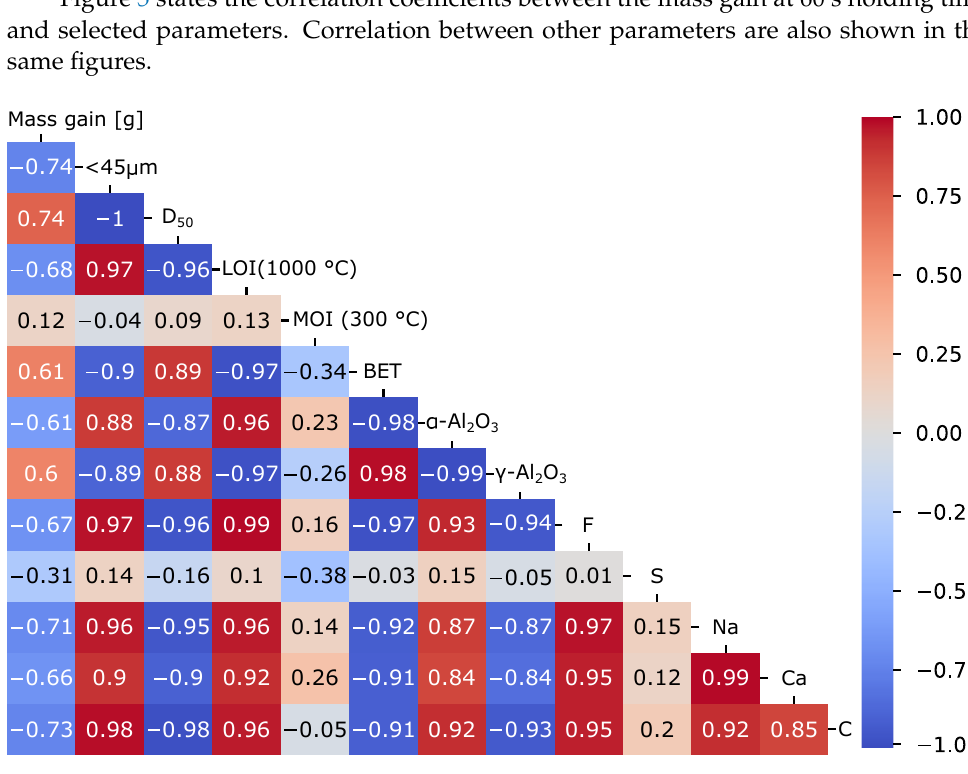
Figure 5. Correlation coefficients between selected parameters and the mass gains of samples after holding time 60 s. < 45 µm is fraction of grains below 45 µm, while D 50 corresponds to the width of the particle size distribution curve shown in Figure